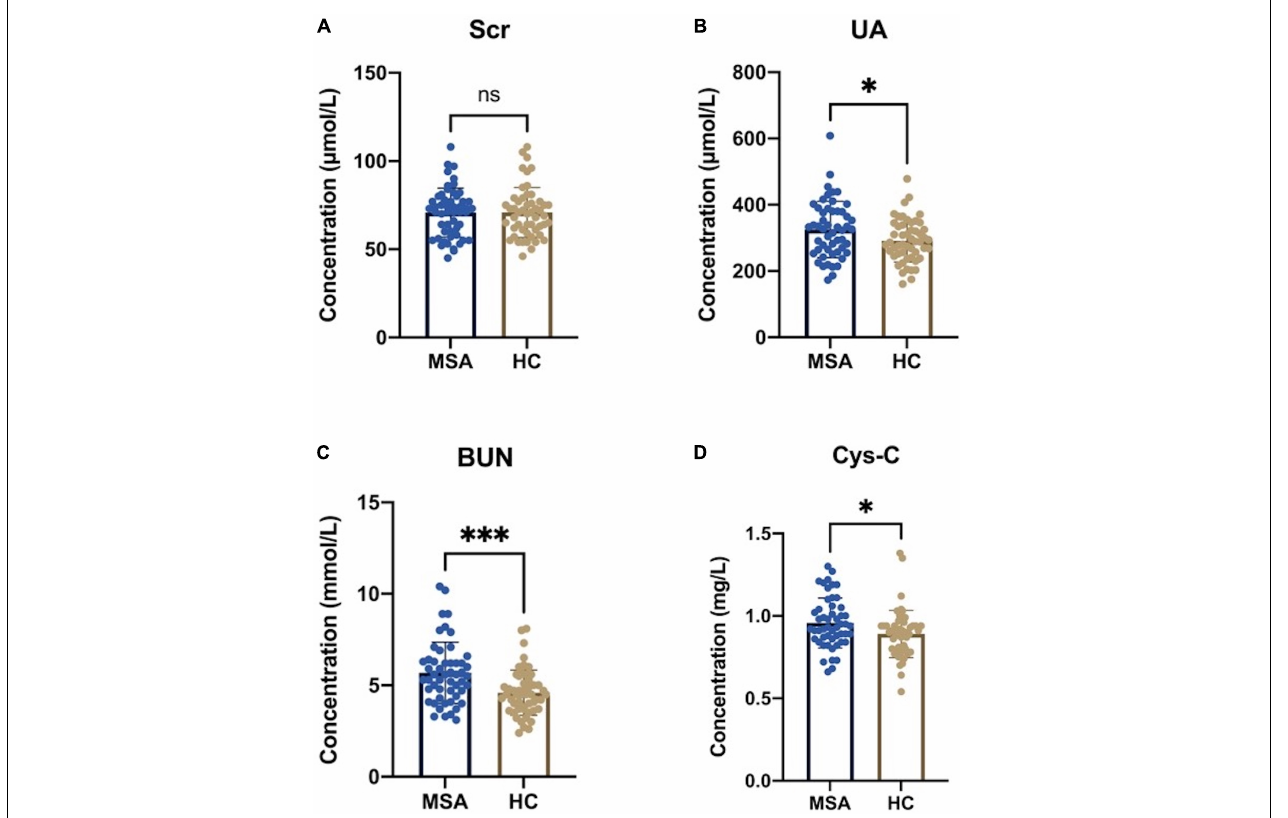
FIGURE 2 | Serum oxidative biomarkers in MSA patients and healthy subjects. (A) There was no statistical significance in serum Scr levels between MSA patients and healthy controls (HCs) (70.81 ± 13.88 vs. 70.92 ± 14.19 µ mol/L, p = 0.967). (B) The serum levels of UA were significantly higher in MSA patients than in HCs (325.31 ± 84.92 vs. 291.19 ± 64.14 µ mol/L, p = 0.023). (C) The serum levels of BUN were significantly higher in MSA patients than in HCs (5.68 ± 1.67 vs. 4.60 ± 1.24 mmol/L, p < 0.001). (D) The serum levels of Cys-C was significantly higher in MSA patients than in HCs (0.96 ± 0.15 vs. 0.89 ± 0.14 mg/L, p = 0.024). The symbol ns is for P > 0.05, * for P < 0.05, ** for P < 0.01, and *** for P < 0.001, retrospectively.